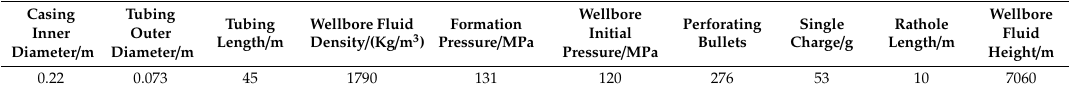
Table 4. Perforation operation parameters.